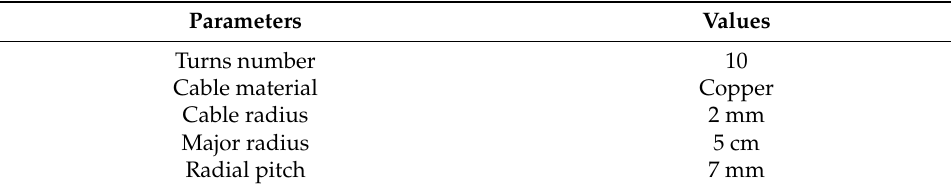
Table 2. Circuit component and parameter values of the two-coil system simulation setup